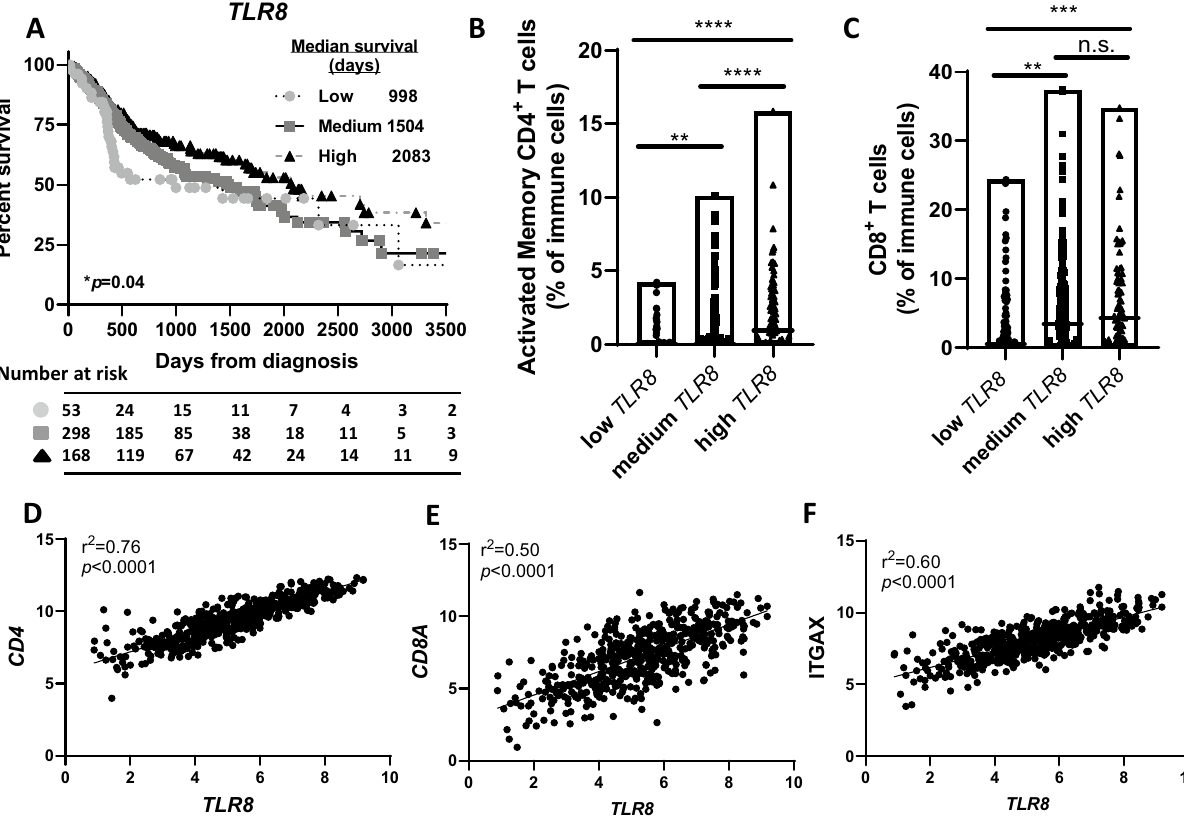
Figure 1. TLR8 gene expression is associated with HNSCC patient survival. ( A ) Shown are Kaplan–Meier survival curves comparing overall survival of HNSCC patients (n = 522) from the TCGA database according to high (n = 91), medium (n = 316) or low (n = 115) TLR8 expression. ( B , C ): Dot-box plots illustrate the percentage of activated memory CD4 + ( B ) and CD8 + ( C ) tumor infiltrating T cells in HNSCC patients with high, medium and low TLR8 expression from ( A ). Error bars represent standard deviation of the mean. ( D – F ) Correlation analysis (Pearson’s correlation tests) between TLR8 and CD4 ( D ), CD8A ( E ) and ITGAX ( F ) of all HNSCC patients from ( A ). **p < 0.01, ***p < 0.001, ****p < 0.0001, n.s.-non-significant (One-way ANOVA, Tukey’s multiple comparison